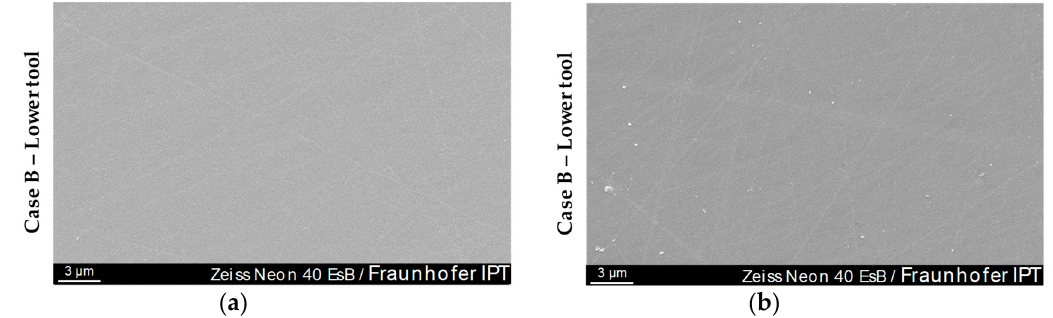
Materials 2018 , 11 , x FOR PEER REVIEW 15 of 21